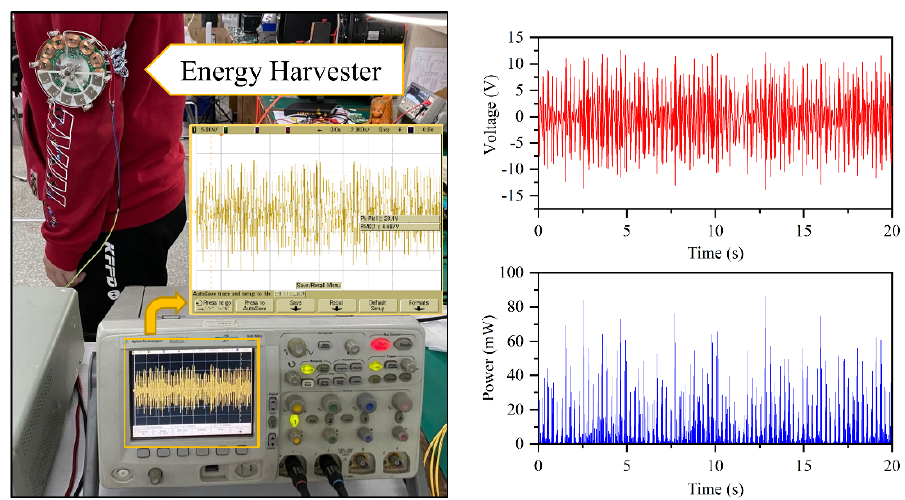
Figure 6. Application demonstration results of human kinetic energy harvesting using the energy harvester: output voltage wave and instantaneous power.